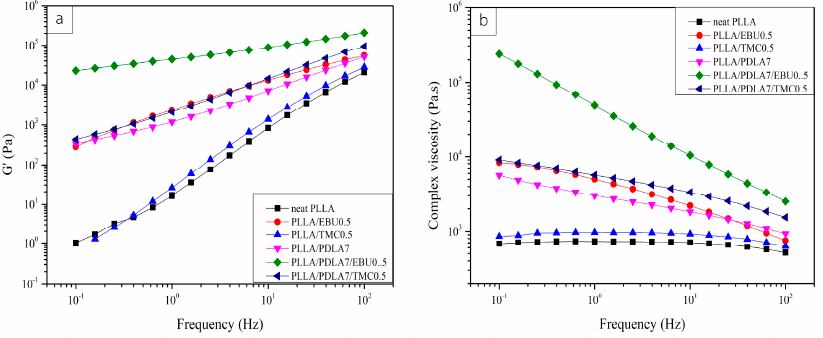
Figure 6. Storage modulus ( a ) complex viscosity ( b ) at various frequency for nucleated PLLA.